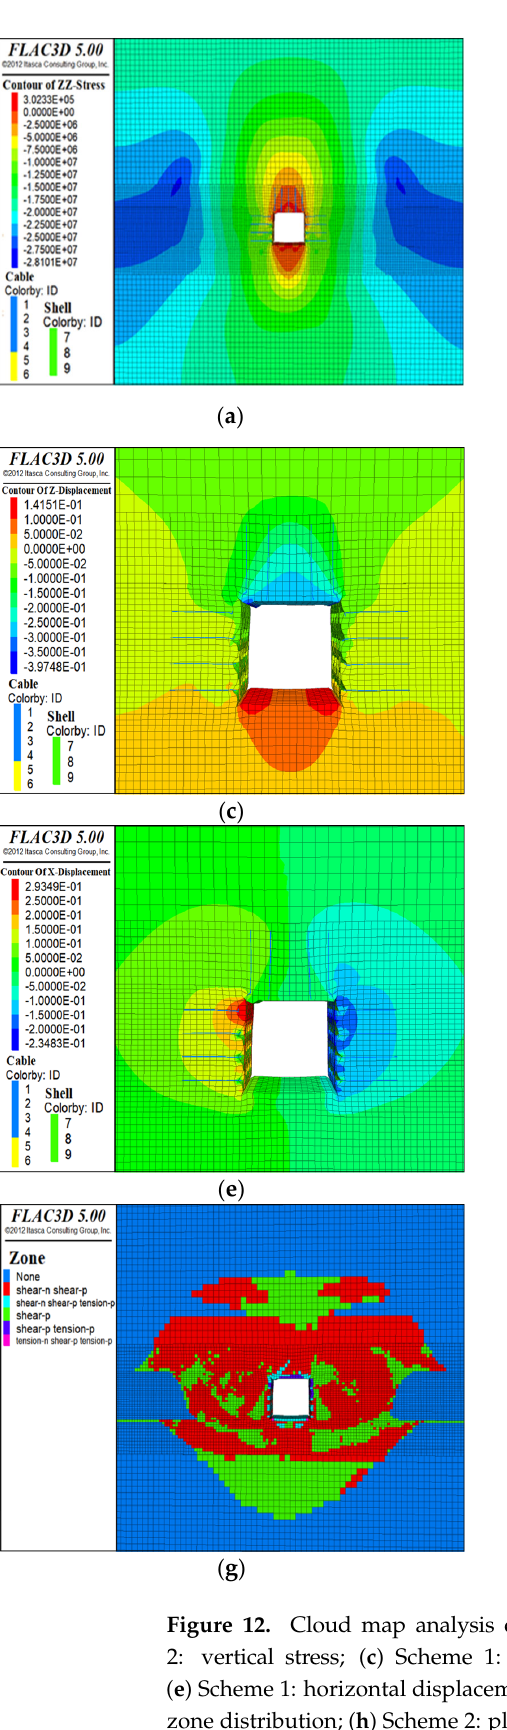
( d ) Figure 11. Roadway monitoring point axis elevation ‐ displacement curve. ( a ) Roof monitoring point z axis elevation ‐ displacement curve; ( b ) Floor monitoring point z axis elevation ‐ displacement curve; ( c ) X axis elevation ‐ displacement curve of left side monitoring point; ( d ) X axis elevation ‐ displace ‐